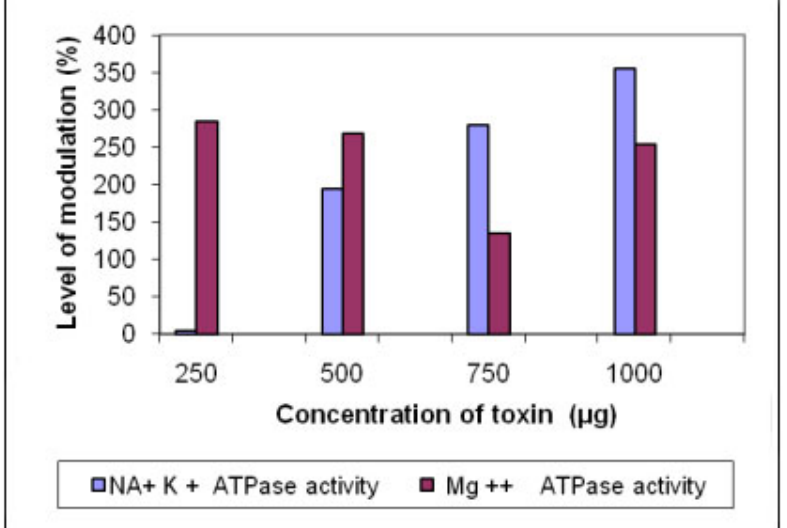
Figure 1. Modulation of Na + -K + ATP-ase and Mg ++ ATP-ase activity by the methanolic extract of Halichondria panicea.